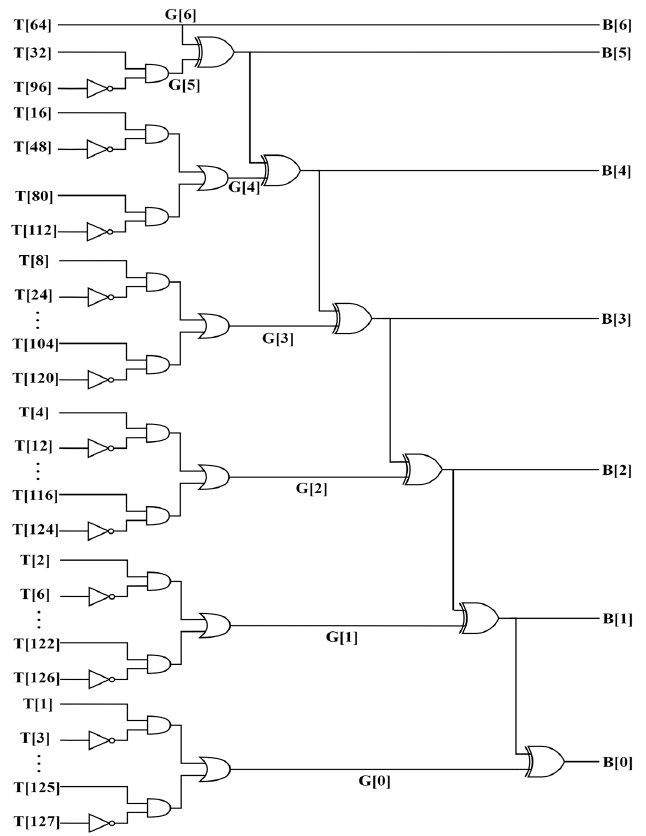
Figure 8. Encoder block.